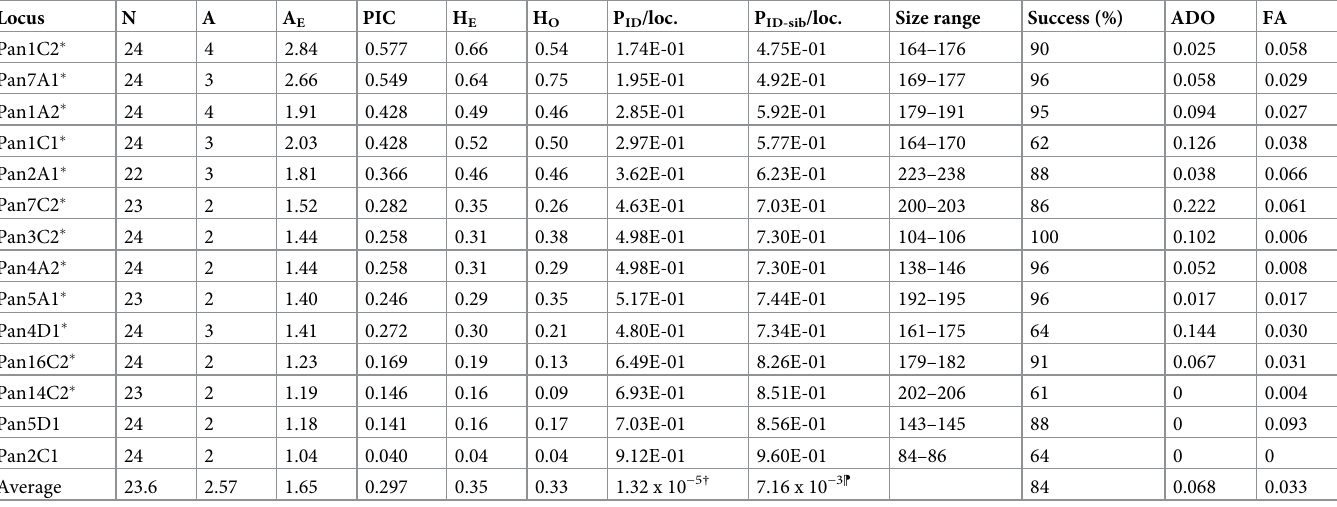
Table 2. Genetic diversity indices of the surveyed Amur leopard population (14 microsatellite markers and 24